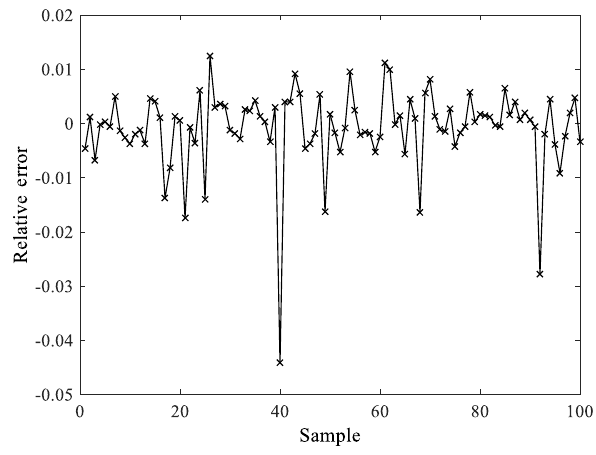
Figure 7. Relative error of the BP-ANN.